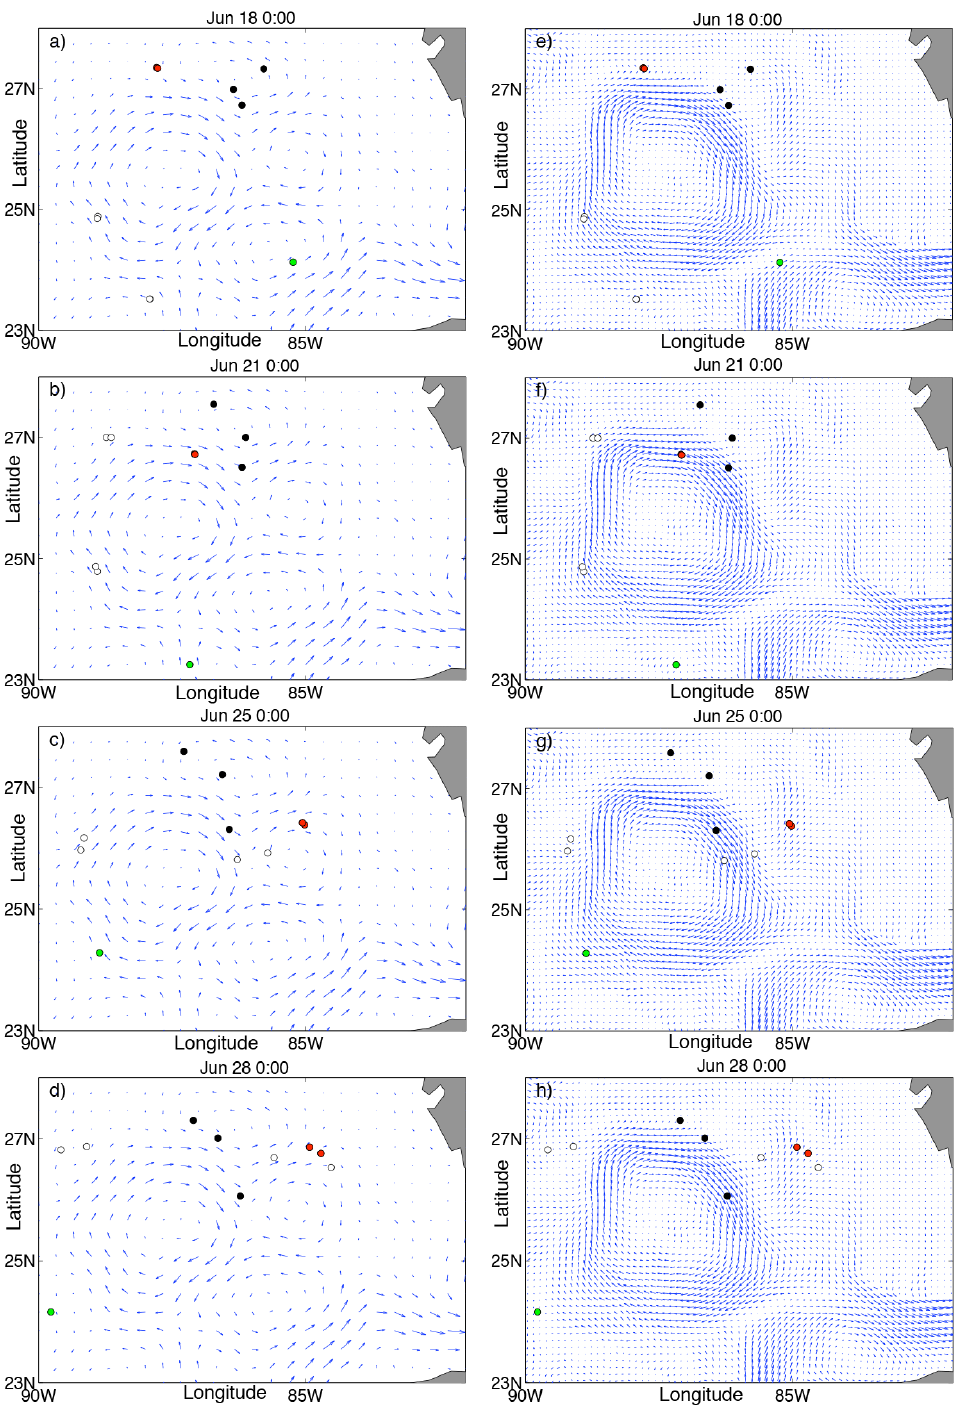
Figure 8. Sequence that shows the evolution of the Eulerian velocities from AVISO data from (a) to (d) and from HYCOM data from (e) to (h) . Drifters of Fig. 7 are depicted with the same color code but without identifiers. It is hard to understand drifter evolution directly from these Eulerian